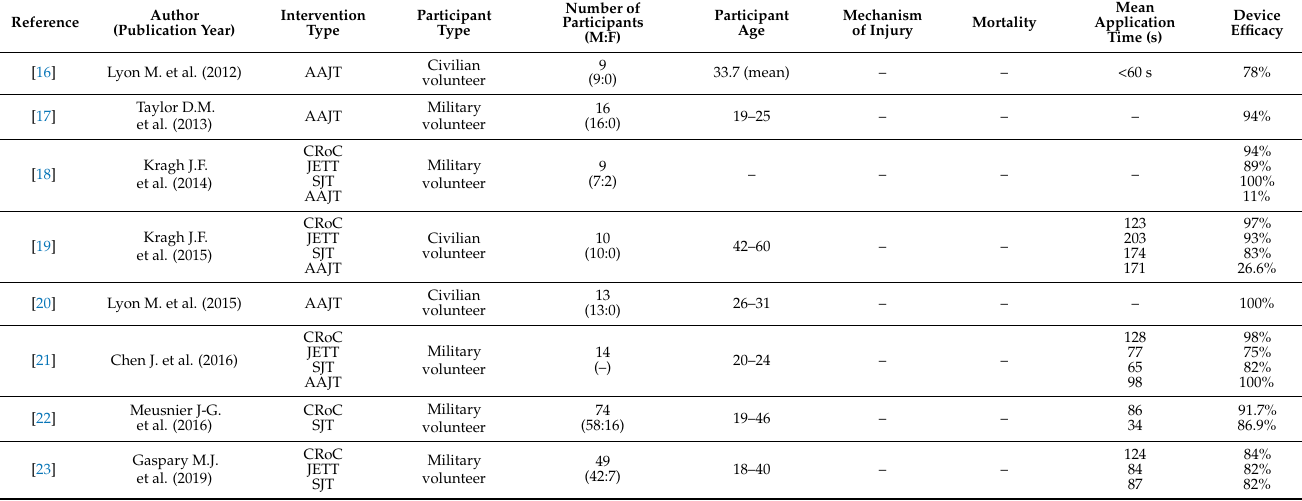
Table 2. Summary of junctional tourniquet study characteristics, patient demographics, and outcome measure results in civilian and military healthy